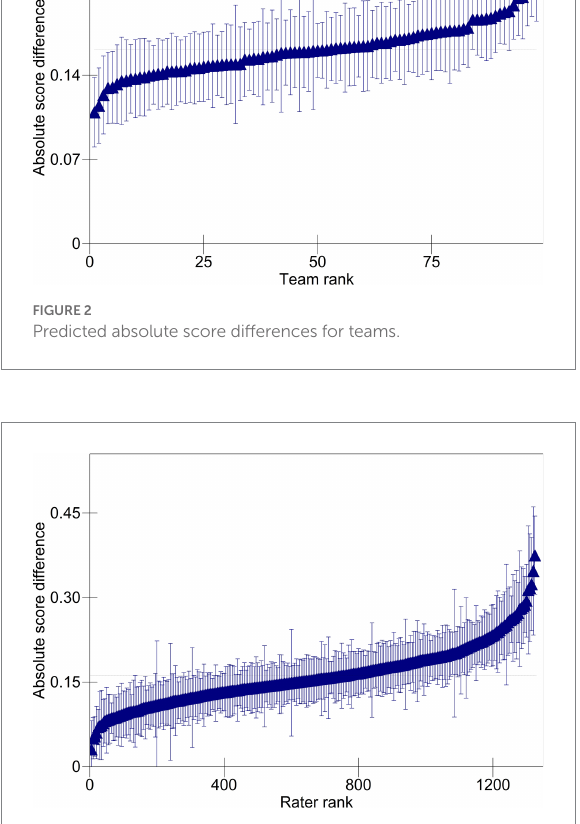
FIGURE 3 Predicted absolute score differences for raters. For clarity, every 5th rater is